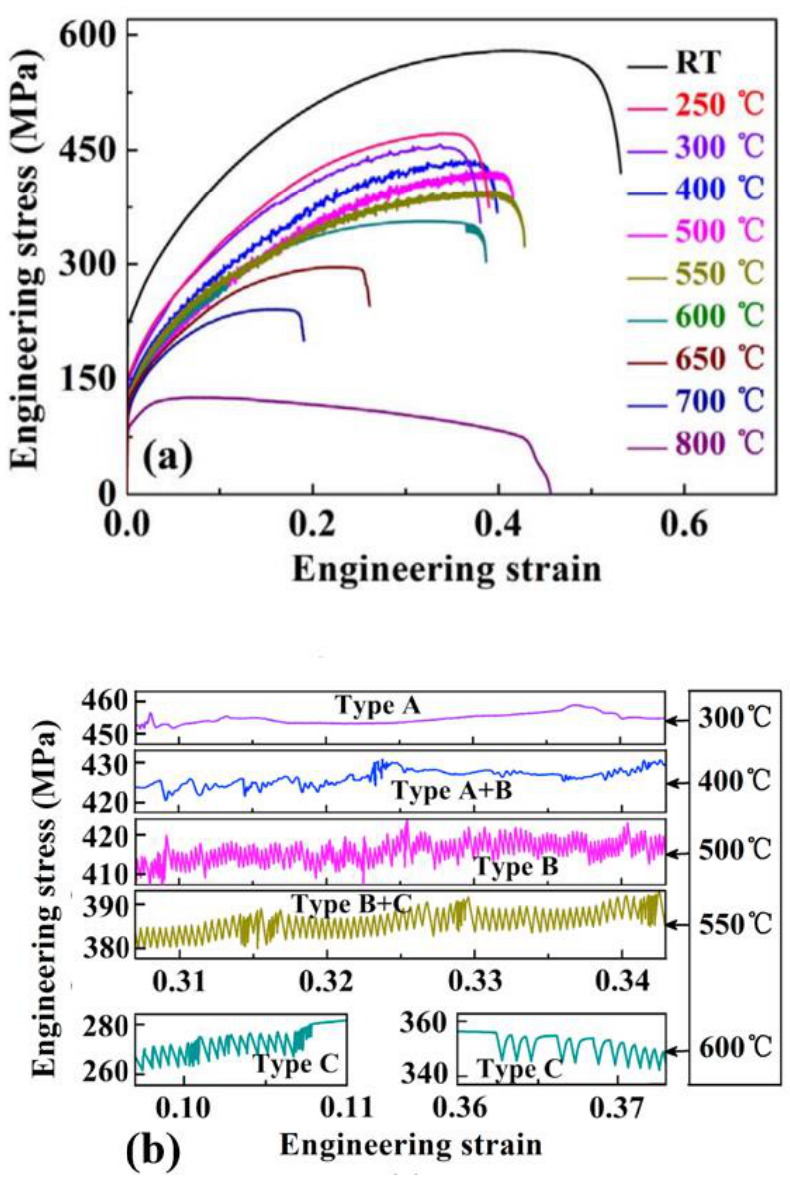
Figure 36. ( a ) Engineering stress–strain curves for the CoCrFeMnNi HEA performed at temperatures ranging from RT to 800 ◦ C and a strain rate of 3 × 10 − 4 s − 1 and ( b ) the partially enlarged segments for ranging from RT to 800 °C and a strain rate of 3 × 10 −4 s −1 and ( b ) the partially enlarged segments for the curves that exhibited serrations (reproduced from Reference [163] with the curves that exhibited serrations (reproduced from Reference [163] with permission).